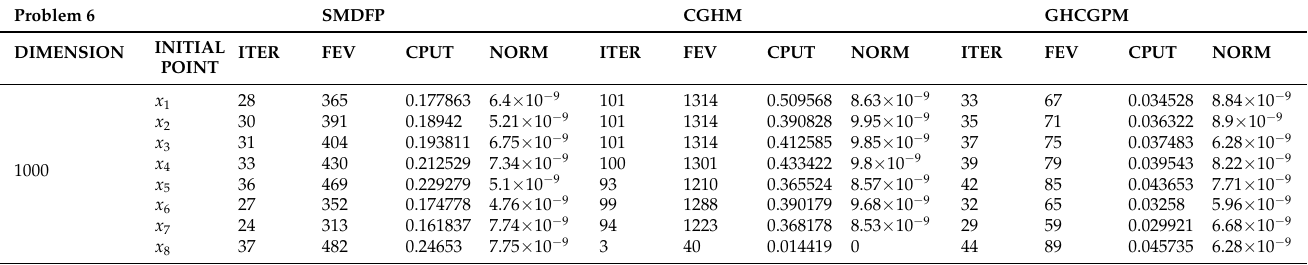
Table 6. Numerical comparison of the SMDFP, CGH [61], and GHCGP [62]